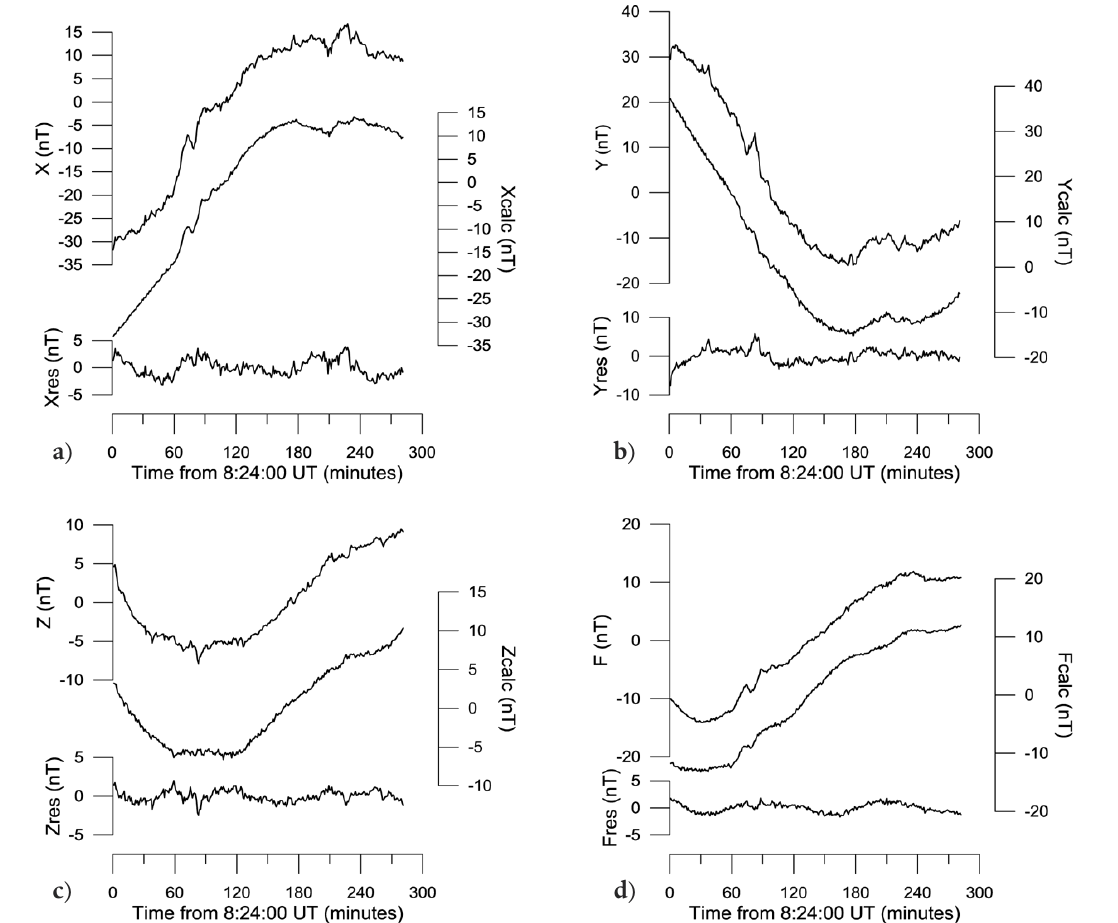
Figure 4. Example of modeling (Cluj station): a) the north component (X); b) the east component (Y); c) the vertical component (Z); d) the total field (F). In each plot the recorded data (upper curve), the calculated values of the model (middle curve) and the residuals (lower curve) are shown.